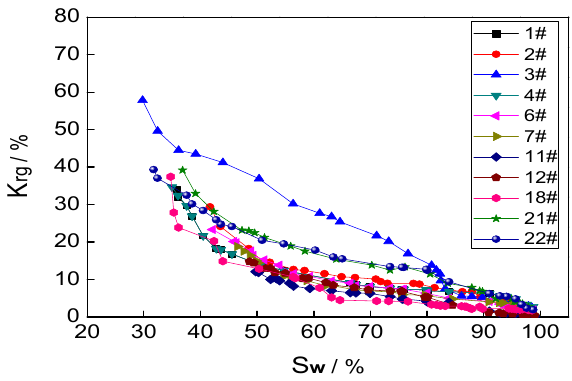
Figure 2—Relative gas permeability under different S w .